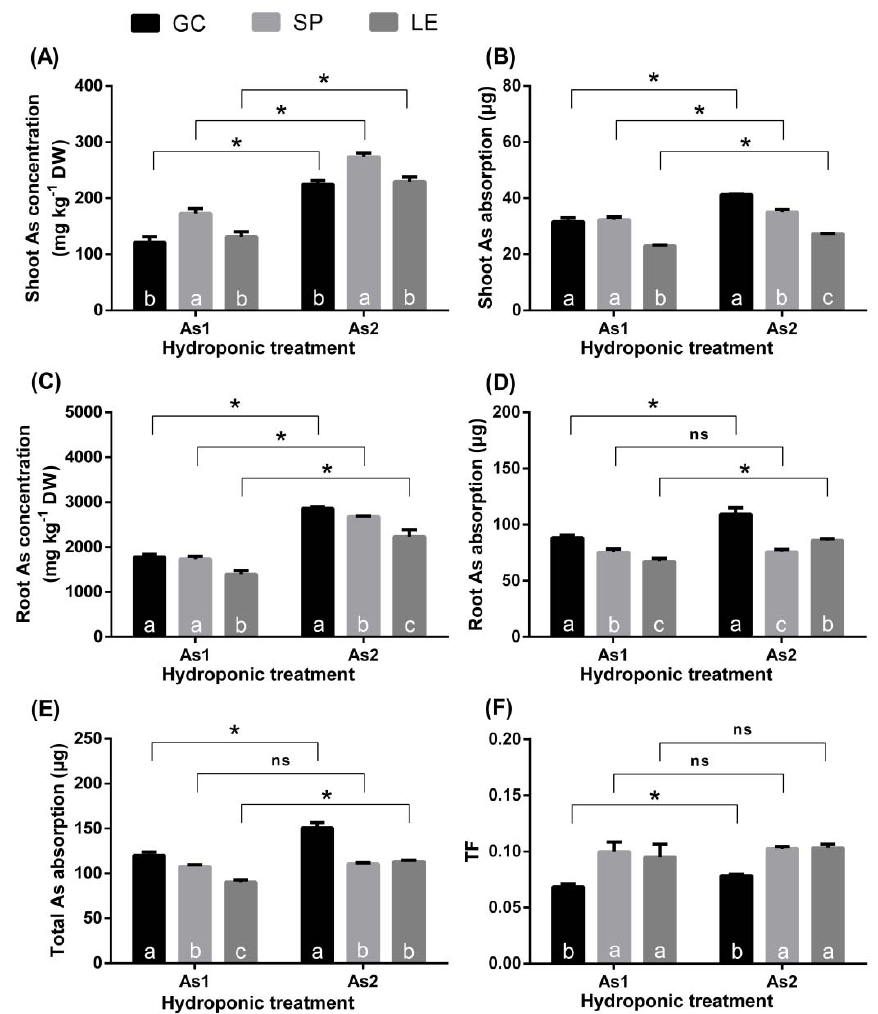
Figure 4. The As concentration ( A , C ), As absorption amount ( B , D , E ), and the root-to-ground TF of As ( F ) under hydroponic culture. Note: Different lowercase letters in the figure indicate comparisons between different vegetables under the same treatment (5% levels). The symbol * indicates that the difference between values is significant at the respective 5% levels. The error bars in the graph indicate the SEM (standard error of the mean).